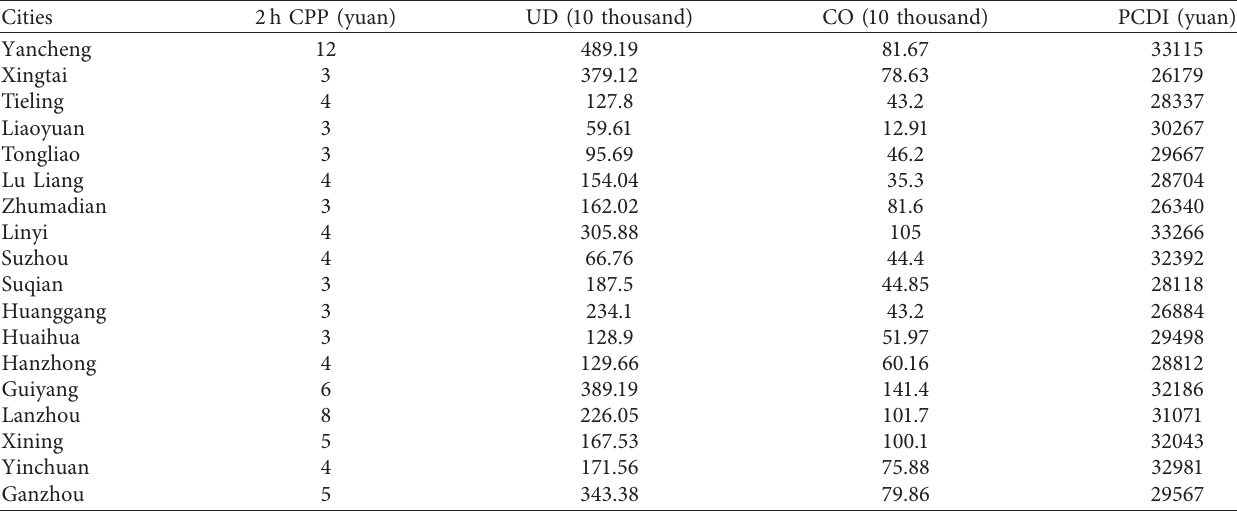
Table 2: The curb parking price in the core areas in PCs